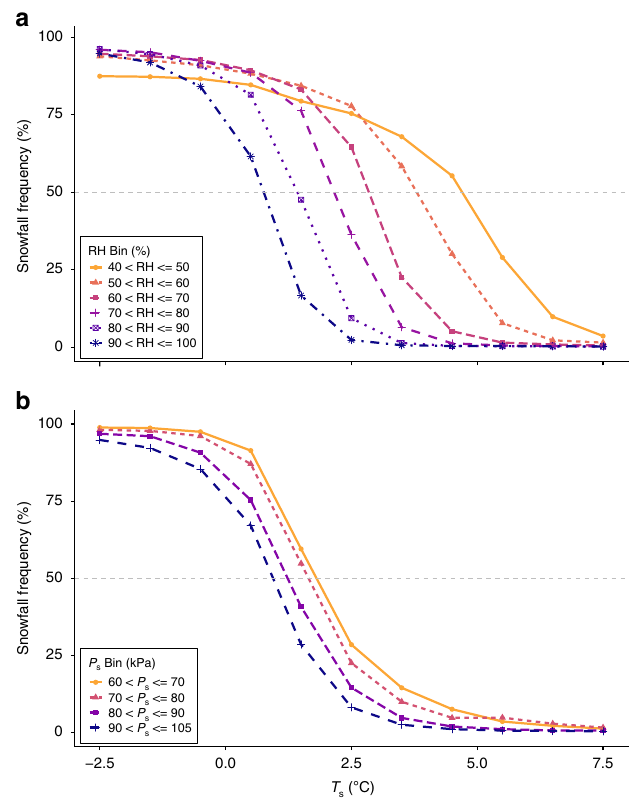
Fig. 2 Snowfall frequency curves calculated using observations from 11,924 stations across the Northern Hemisphere (1978 – 2007). a Snowfall frequency curves plotted by RH bin. b Snowfall frequency curves plotted by P – snow T P s bin. The 50% rain s threshold for each of the RH and s bins are as follows: 4.5 °C (40 – 50%), 3.7 °C (50 – 60%), 2.8 °C (60 – 70%), 2.2 °C (70 – 80%), 1.4 °C (80 – 90%), 0.7 °C (90 – 100%), 1.9 °C (60 – 70 kPa); 1.7 °C (70 – 80 kPa), 1.3 °C (80 – 90 kPa), and 0.9 °C (90 – 105 kPa). Standard error bars are not plotted due to the large number of observations per RH, P T s , and s bin (all standard errors are less than 0.9%). (The snowfall frequency curves for all Northern Hemisphere observations by T s , T w , and T d are available in Supplementary Fig.